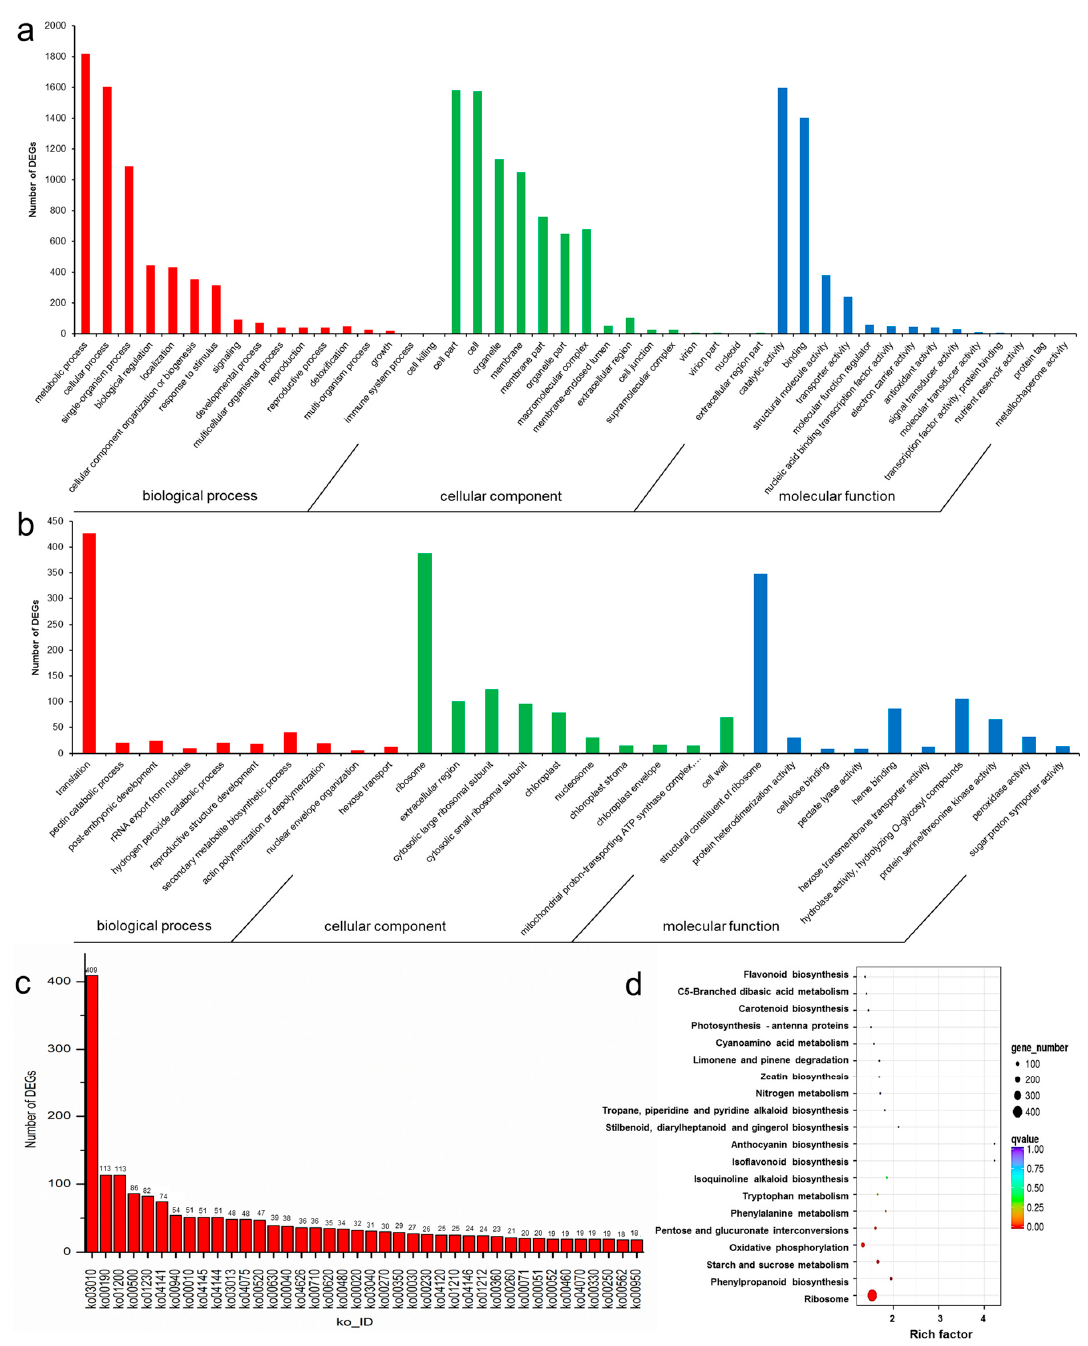
Figure 4. GO and KEGG analysis of DEGs in root and rhizome. ( a ) GO classification of DEGs in root and rhizome, ( b ) GO enrichment of DEGs in root and rhizome, ( c , d ) KEGG classification and KEGG enrichment of DEGs in root and rhizome.